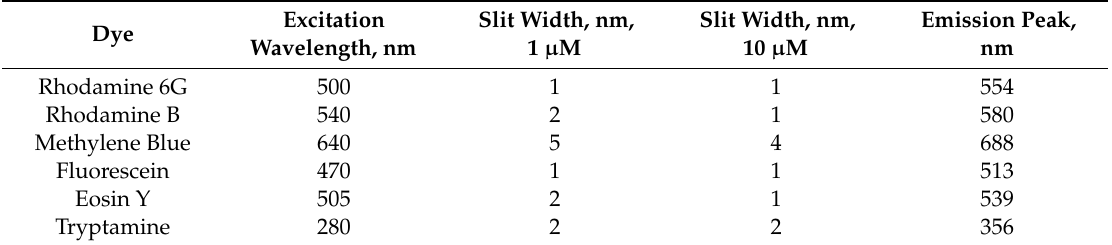
Table 1. Parameter and instrumental setup for fluorescence